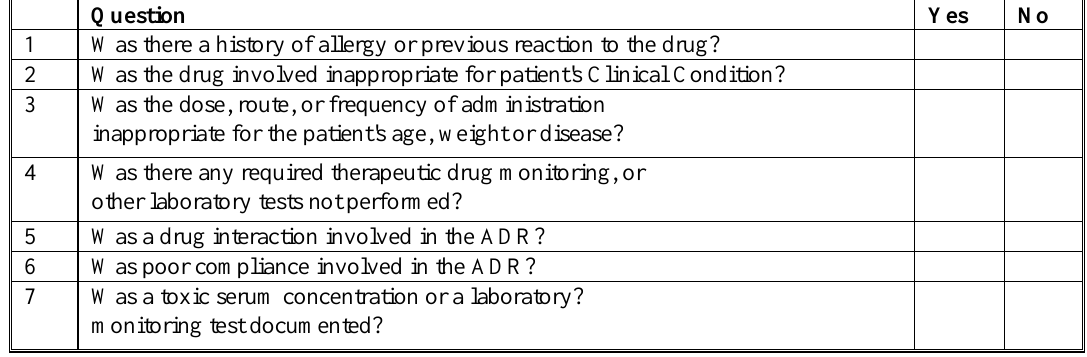
Table 3. Schumock and Thornton preventability assessment criteria (18,19) .